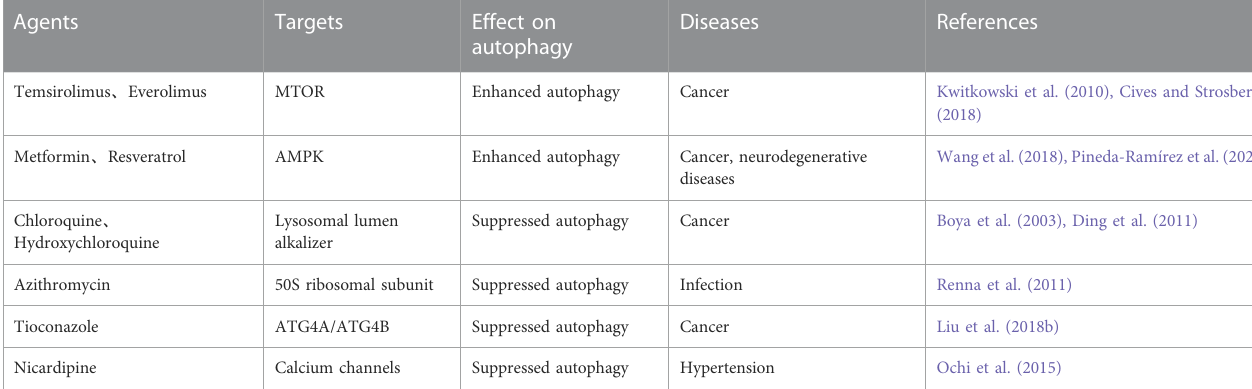
TABLE 1 Application of approved autophagy modulators in